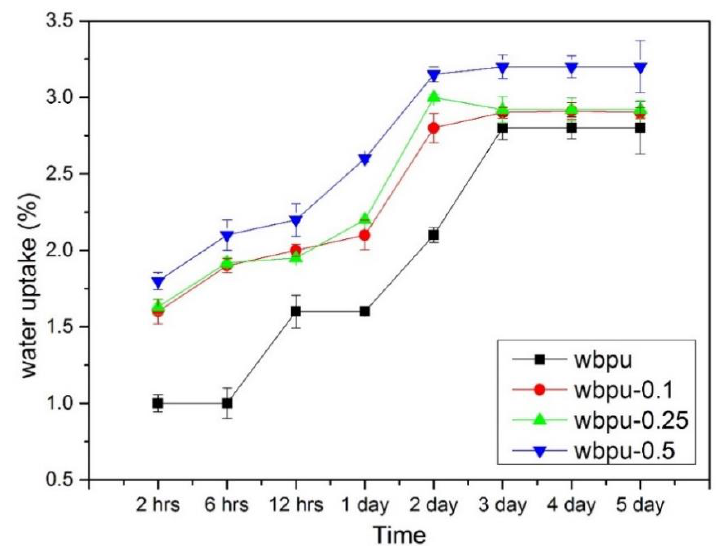
Figure 8. Water uptake of WBPU and WBPU-CNF nanocomposite films.